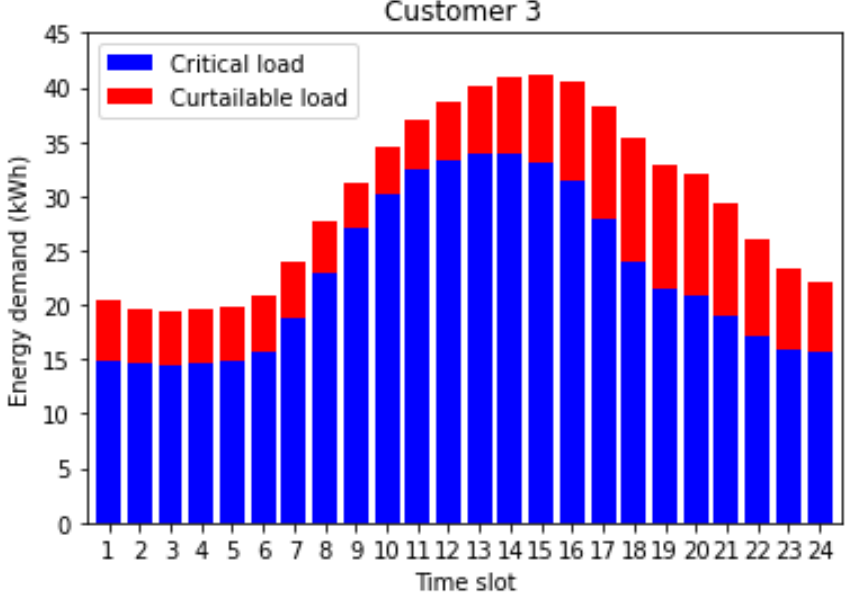
Figure 12. Critical and curtailable load for customer